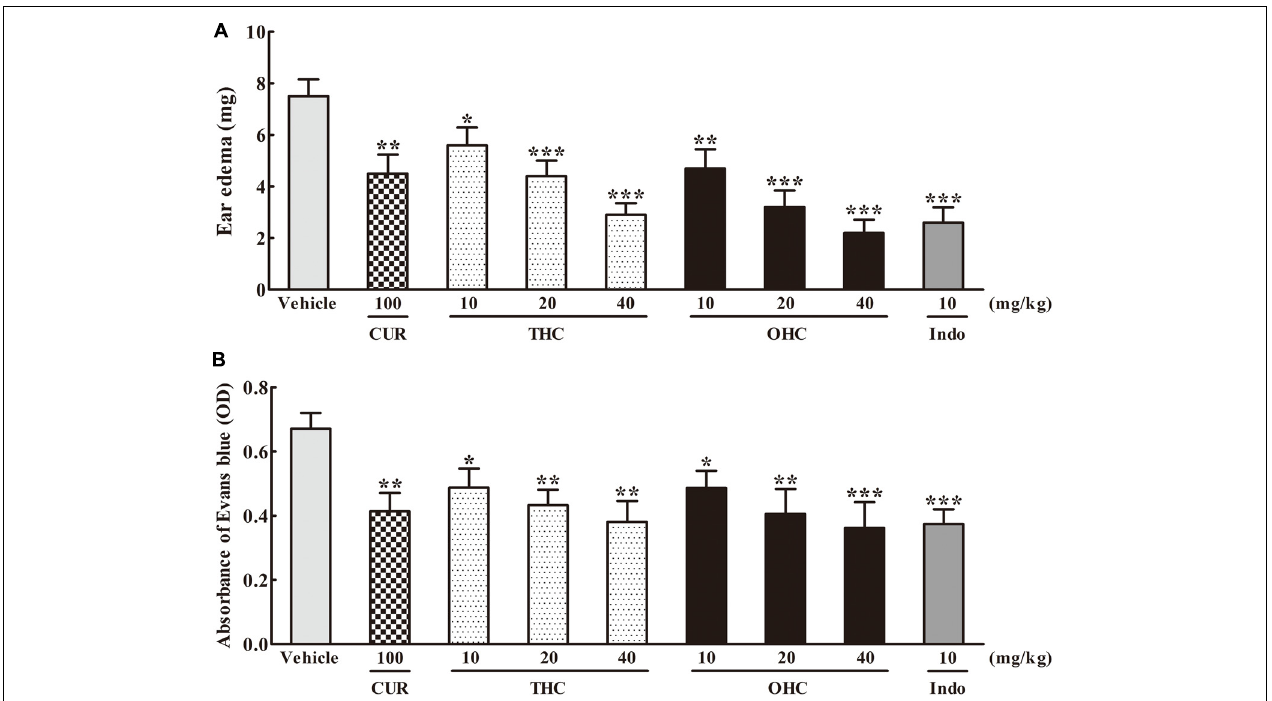
FIGURE 2 | Effects of THC and OHC on the xylene-induced ear edema in mice (A) and acetic acid-induced vascular permeability in mice (B) . (A) The ear edema was assessed as the weight difference between the left and the right ear biopsies of the same animal. (B) The capillary permeability was represented as the amount of Evans blue extruded into peritoneal cavity, which was measured by the OD of the supernatant. Data were expressed as means ± S.E.M. ( n = 10), ∗ p < 0.05, ∗∗ p < 0.01, ∗∗∗ p < 0.001 vs. the vehicle control. Significant differences between groups were determined by ANOVA and Dunnett’s post hoc test.